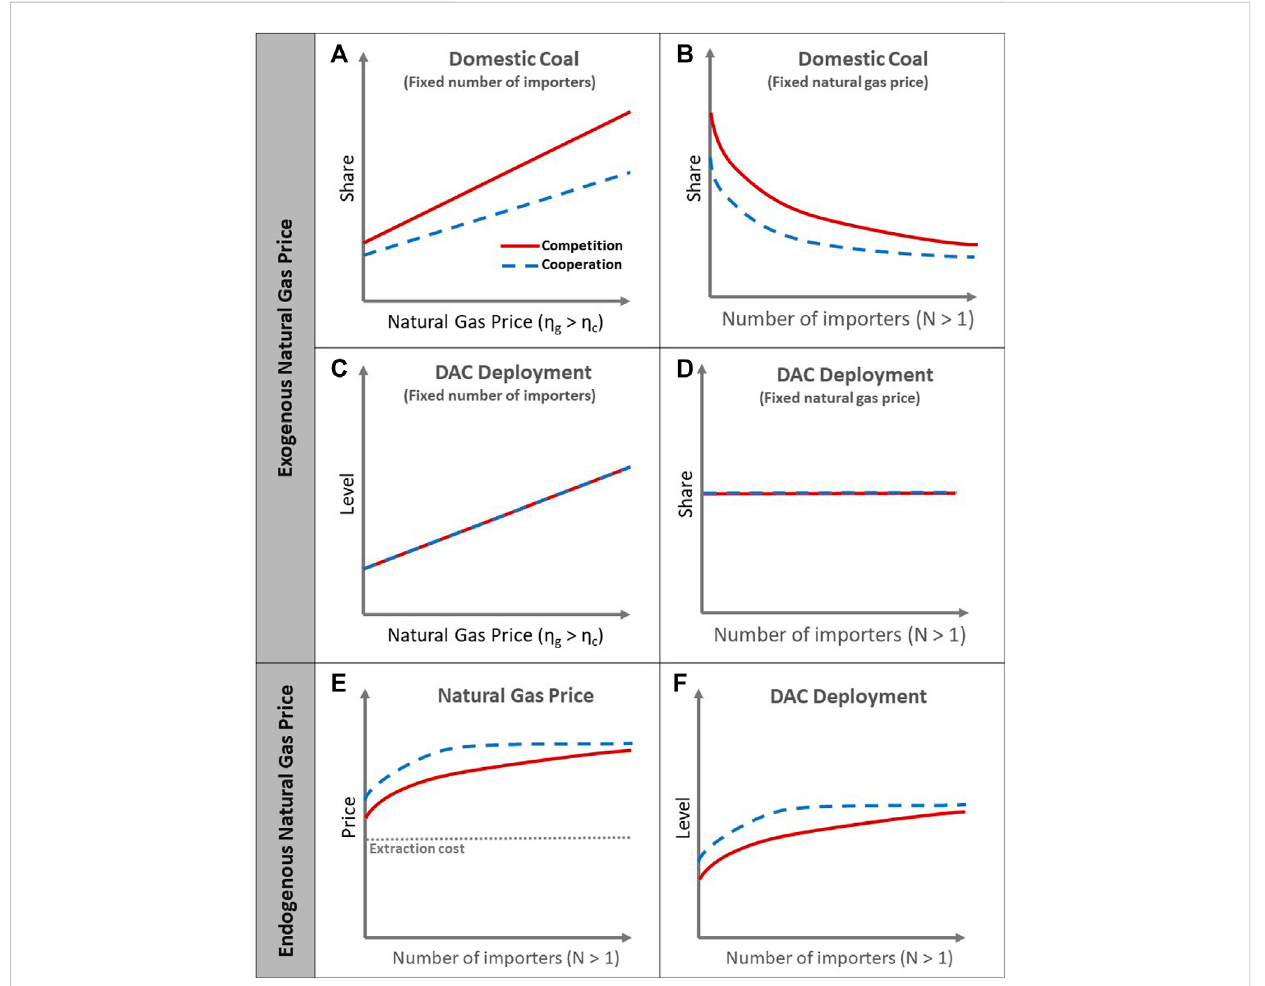
FIGURE 2 Natural gas prices impact in two cases of cooperation and competition with exogenous natural gas prices (A – D) or endogenous natural gas prices (E,F) : (A) optimal share of domestic coal with a fi xed number of importers, (B) optimal share of domestic coal with a fi xed natural gas price, (C) optimal level of DAC deployment with a fi xed number of importers, (D) optimal level of DAC deployment with a fi xed natural gas price, (E) natural gas price with varying number of importing entities, and (F) DAC deployment levels with varying number of importing